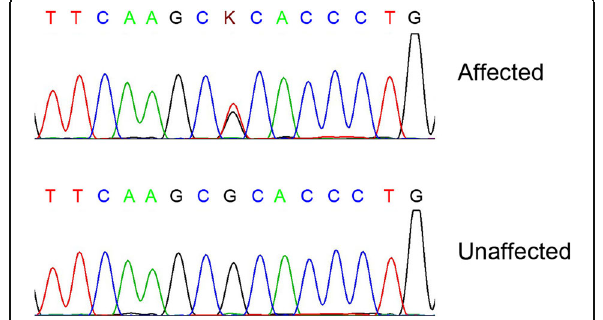
Fig. 3 A novel missense mutation (c.35G> T; p.R12L) in CRYAA in a Chinese family with cataracts and microphthalmia. DNA sequences of CRYAA in affected and unaffected individuals. A heterozygous variant c.35G > T was identified in exon 1 of CRYAA . The upper chromatogram of the DNA sequence from the affected proband (IV: 1) shows both G and T (K) at position 35; thus, the nucleotide variant resulted in the substitution of an arginine for a leucine at codon 12 (p.R12L). The lower sequence chromatogram from an unaffected individual (II: 1) shows only the wild-type CRYAA allele